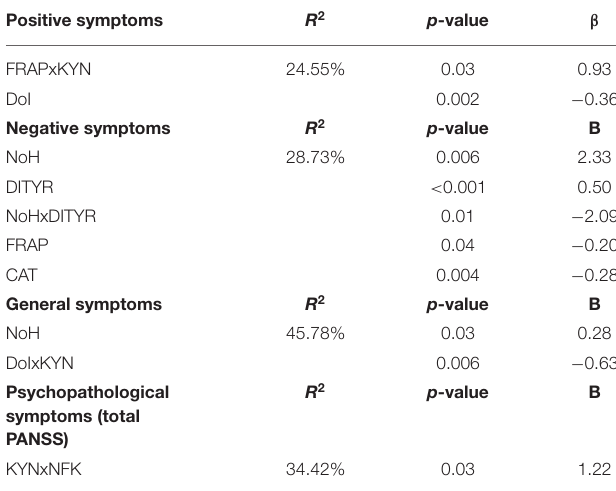
TABLE 4 | The oxidation-related predictors of psychopathological symptoms in schizophrenia: multiple